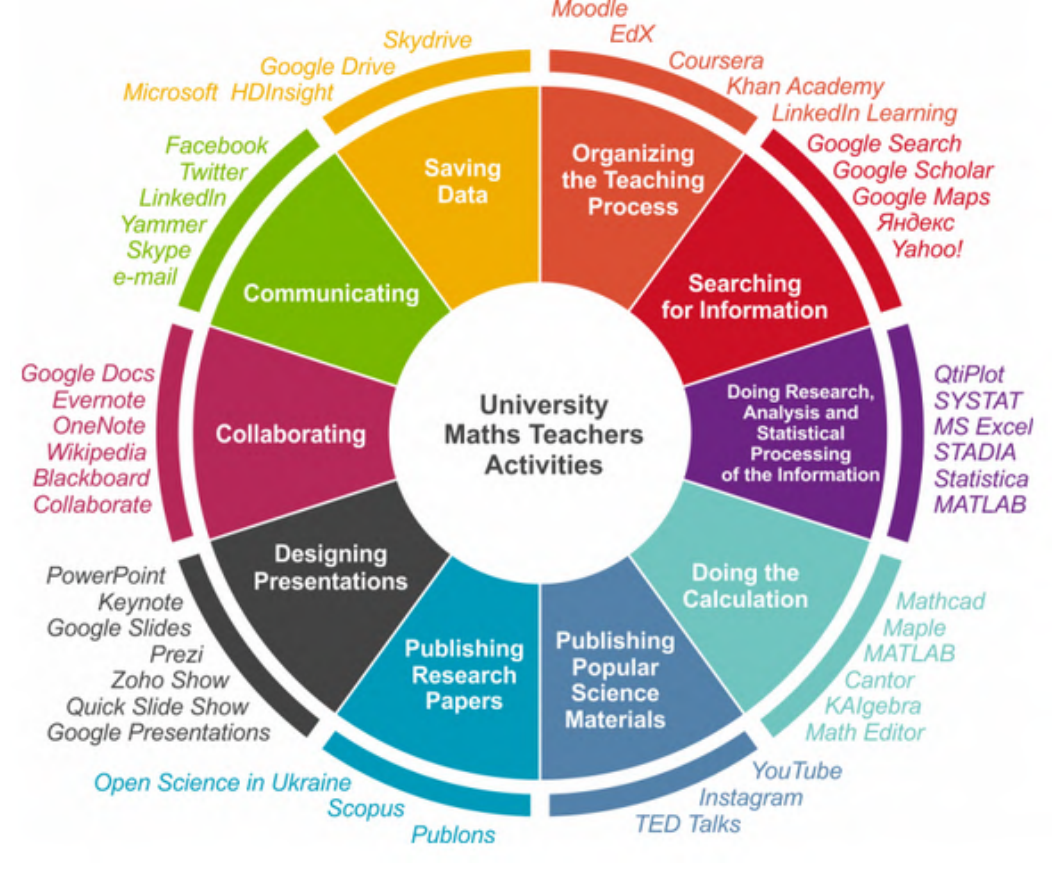
Figure 15: Presentation of paper